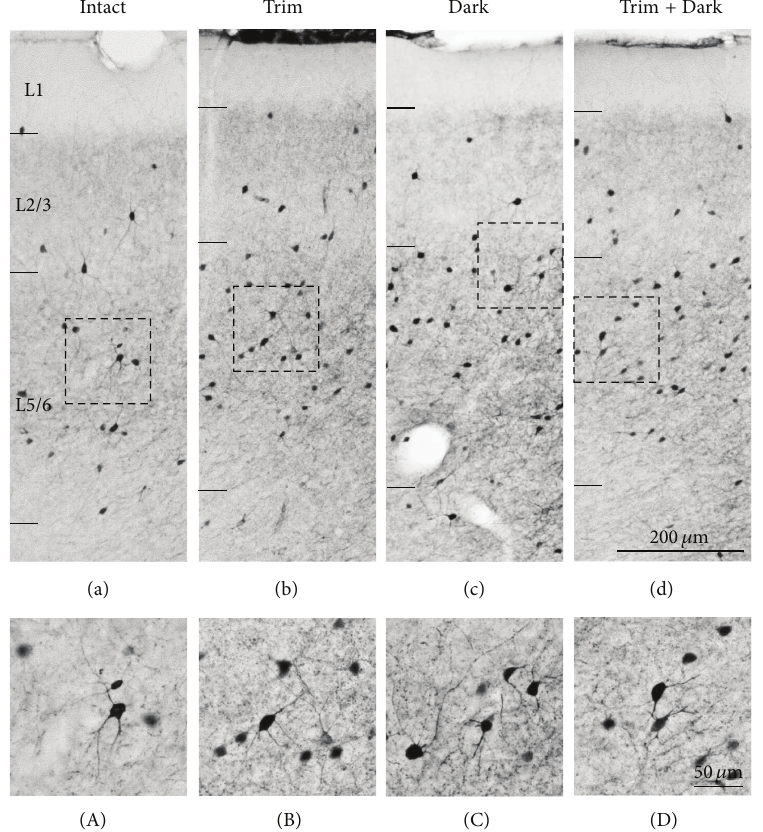
Figure 5: Effects of sensory deprivation on PV neurons in the PL at P56. Whisker trimmed mice (b), dark reared mice (c), and whisker trimmed and dark reared mice (d) have more PV neurons than intact mice (a). (A)–(D) Higher magnification images of PV neurons in the PL. Intact: intact control, trim: whisker trimming, dark: dark rearing, and trim + dark: whisker trimming plus dark rearing. Scale bars = 200 𝜇 m in (d) (applies to (a)–(d)); 50 𝜇 m in (D) (applies to